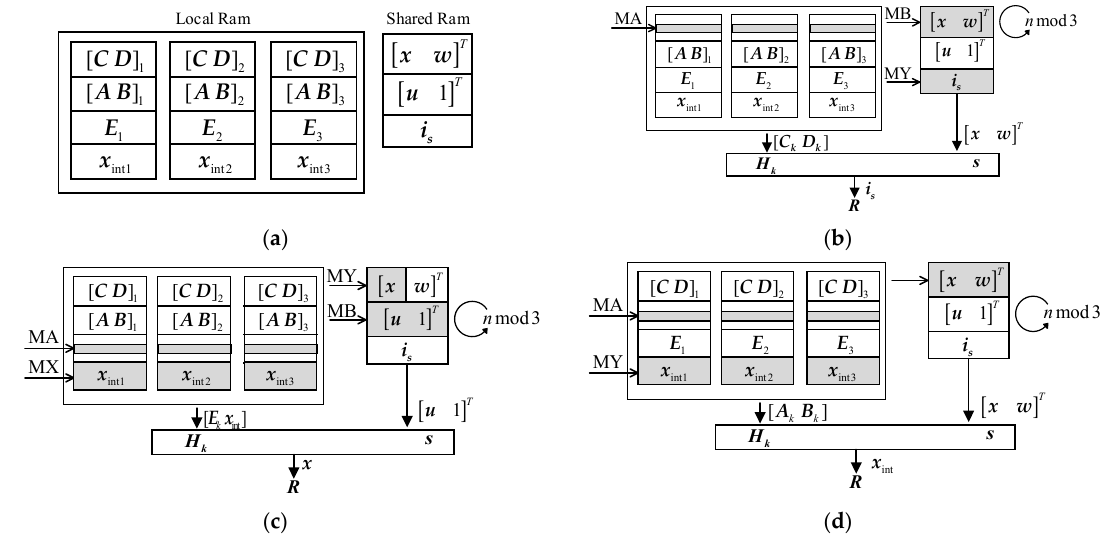
Figure 6. Data storage design of AMA. ( a ) Data storage order of AMA; ( b ) Data addressing requirements and process of i S ( t ) task; ( c ) Data addressing requirements and process of x int ( t ) task; ( d ) Data addressing requirements and process of x ( t )